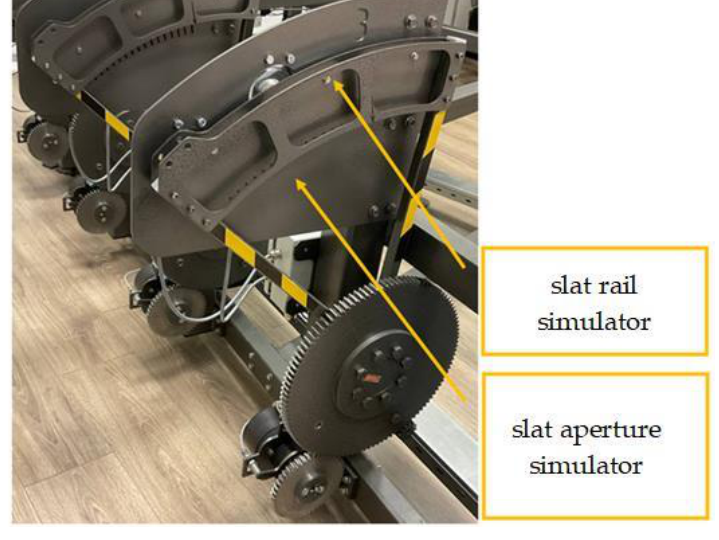
Figure 11. Slat simulator.